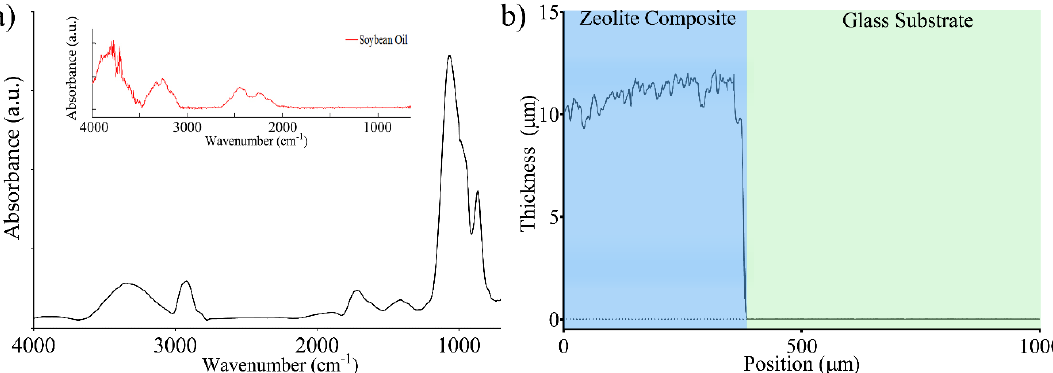
Figure 4. ( a ) FTIR Analysis of the zeolite composite layer, with the soybean oil spectrum in the inset. ( b ) Profilometric analysis of a sample of 10 µ m in